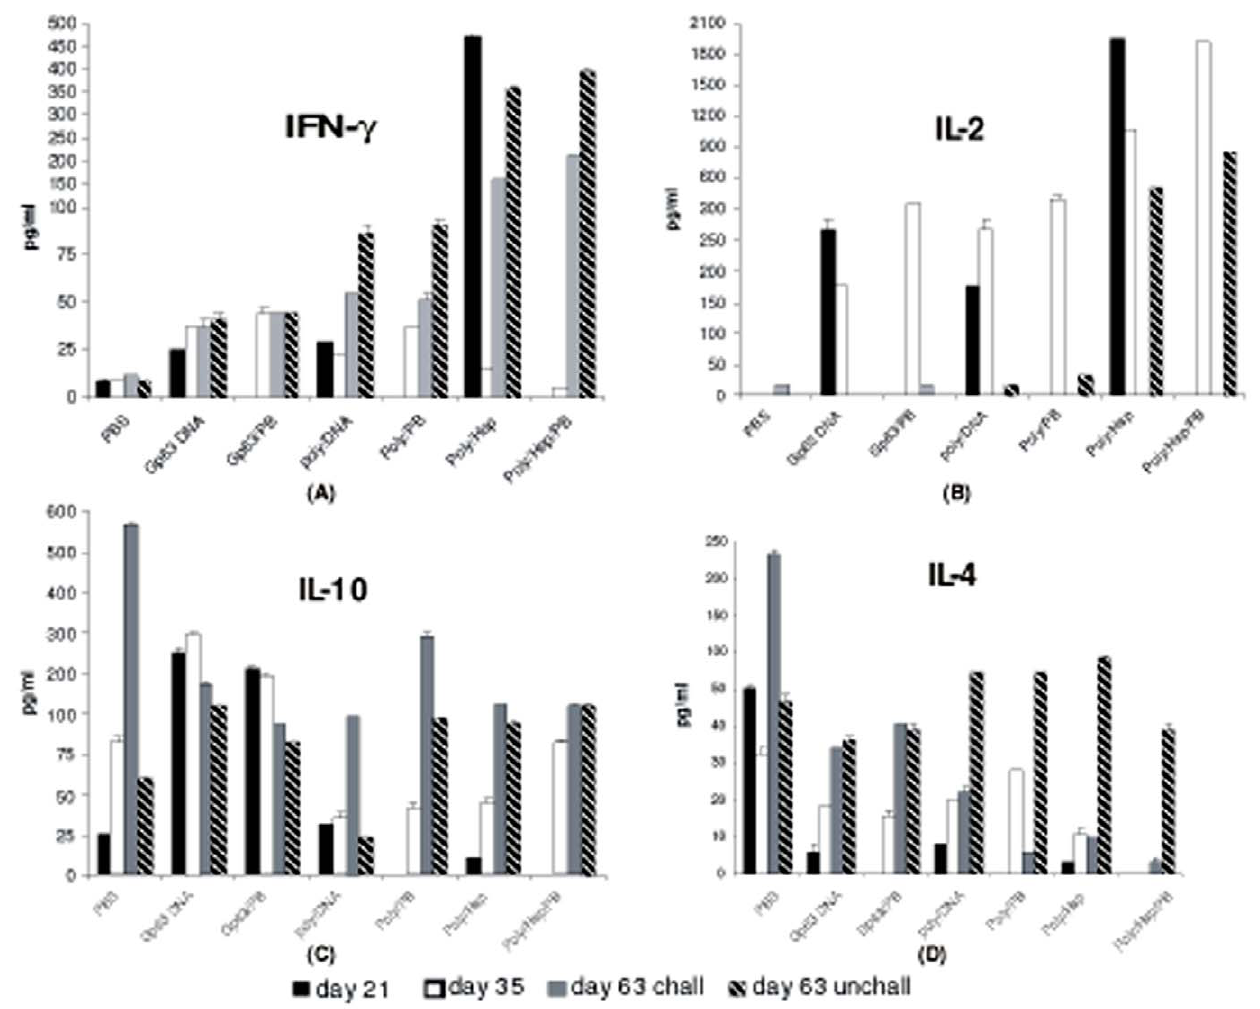
Figure 4. IFN- c , IL-2, IL-4 and IL-10 production on day 21, day 35 and day 63 in all the vaccinated and control groups (6 mice per group) as shown in Fig. 2. Culture supernatants were collected and the cytokines were assayed by flow cytometry. Results presented represent the mean 6 SD (vertical lines on bars) of the triplicate assays.